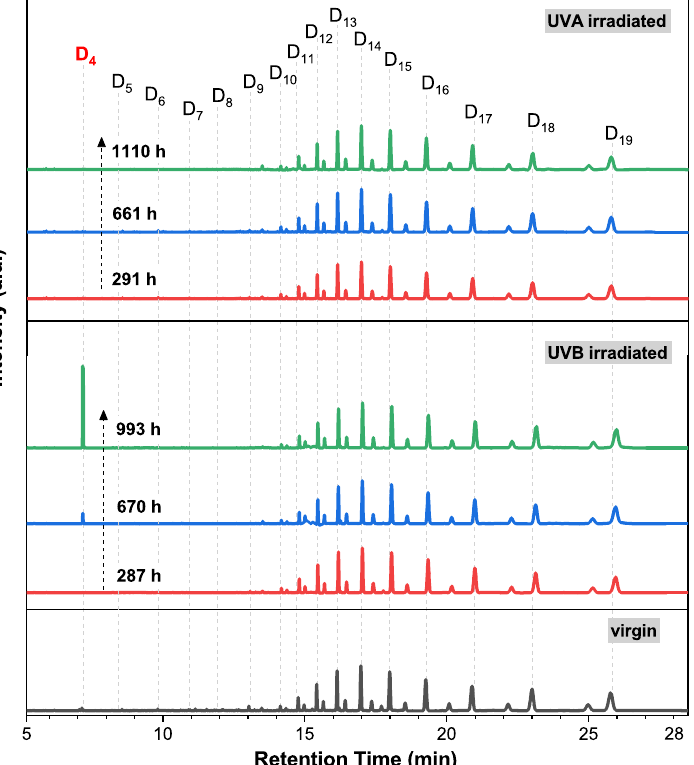
Figure 3. GC peak variations of the silicone rubber extracts after different durations of UVA and UVB irradiation.